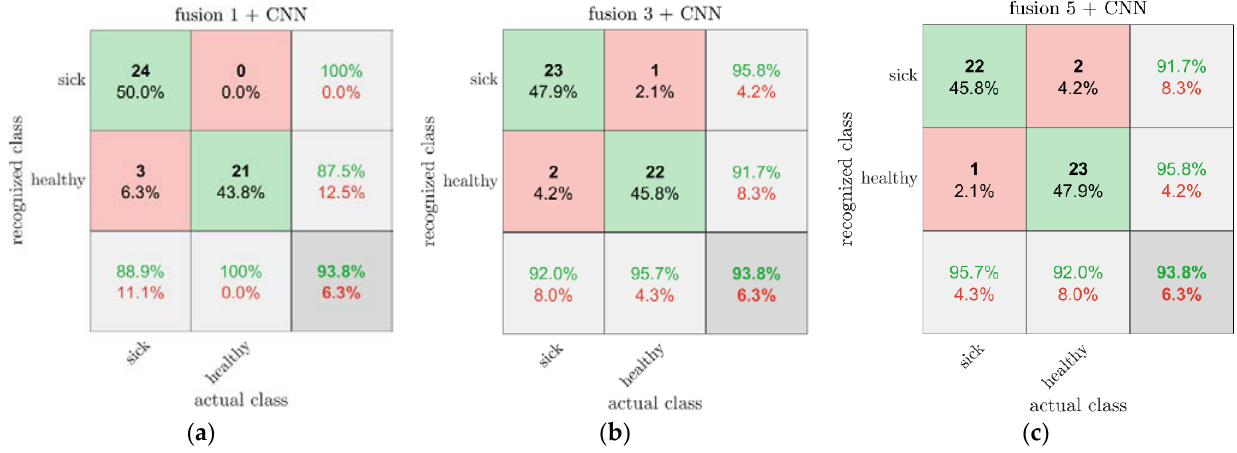
Figure 7. Error matrices obtained when recognizing hypomimia using CNN and fusion images: ( a ) fusion 1, ( b ) fusion 3, ( c ) fusion 5.